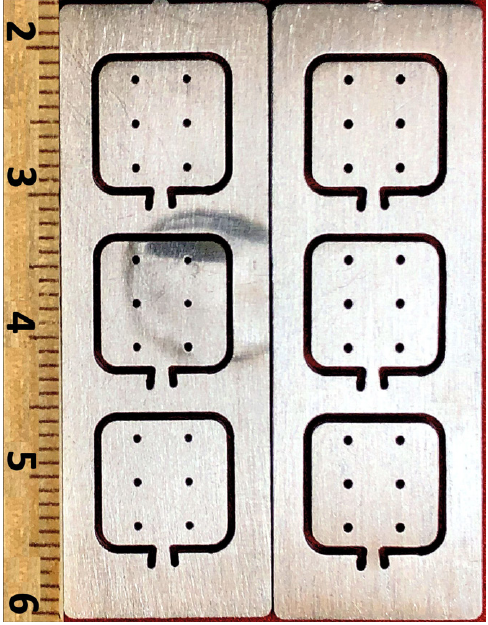
Figure 15: Small hole drilled with Mini Piercer on aluminum lami-